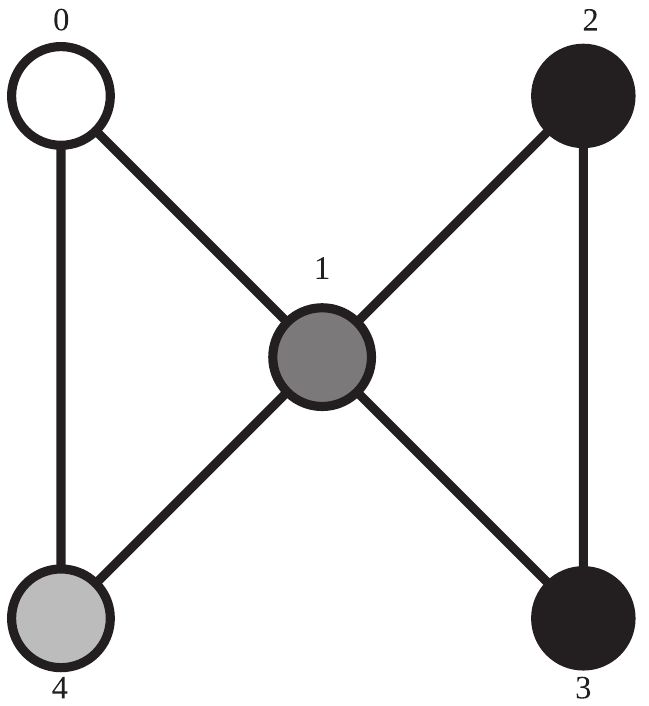
Fig 7. Orbit representative 43. Vertex 0 is marked and cannot be permuted. Vertices colored the same shade of gray are in the same